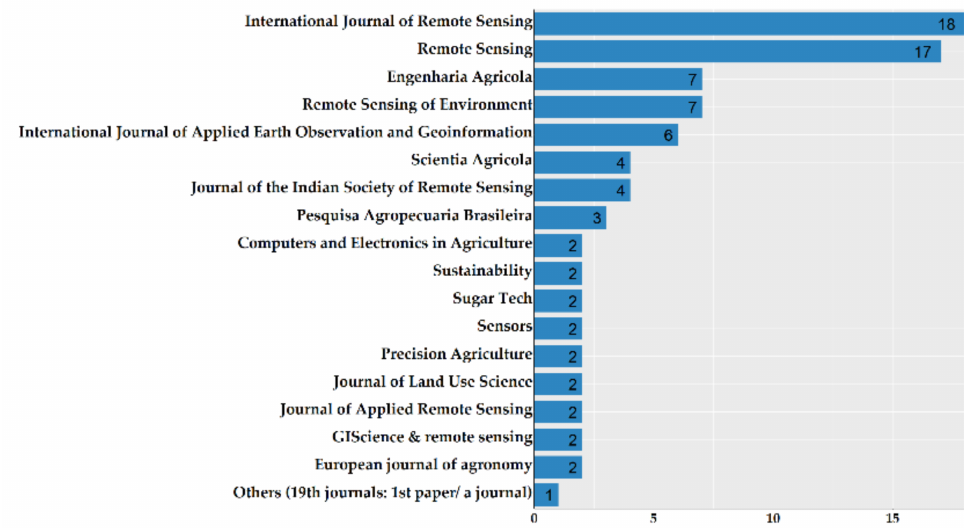
Figure 9. Distribution of sugarcane related publications across journals in Scopus database and Web of Science. The data assessed cover the period 1981 to 2020. The frequency distribution of papers within the different journals is shown.